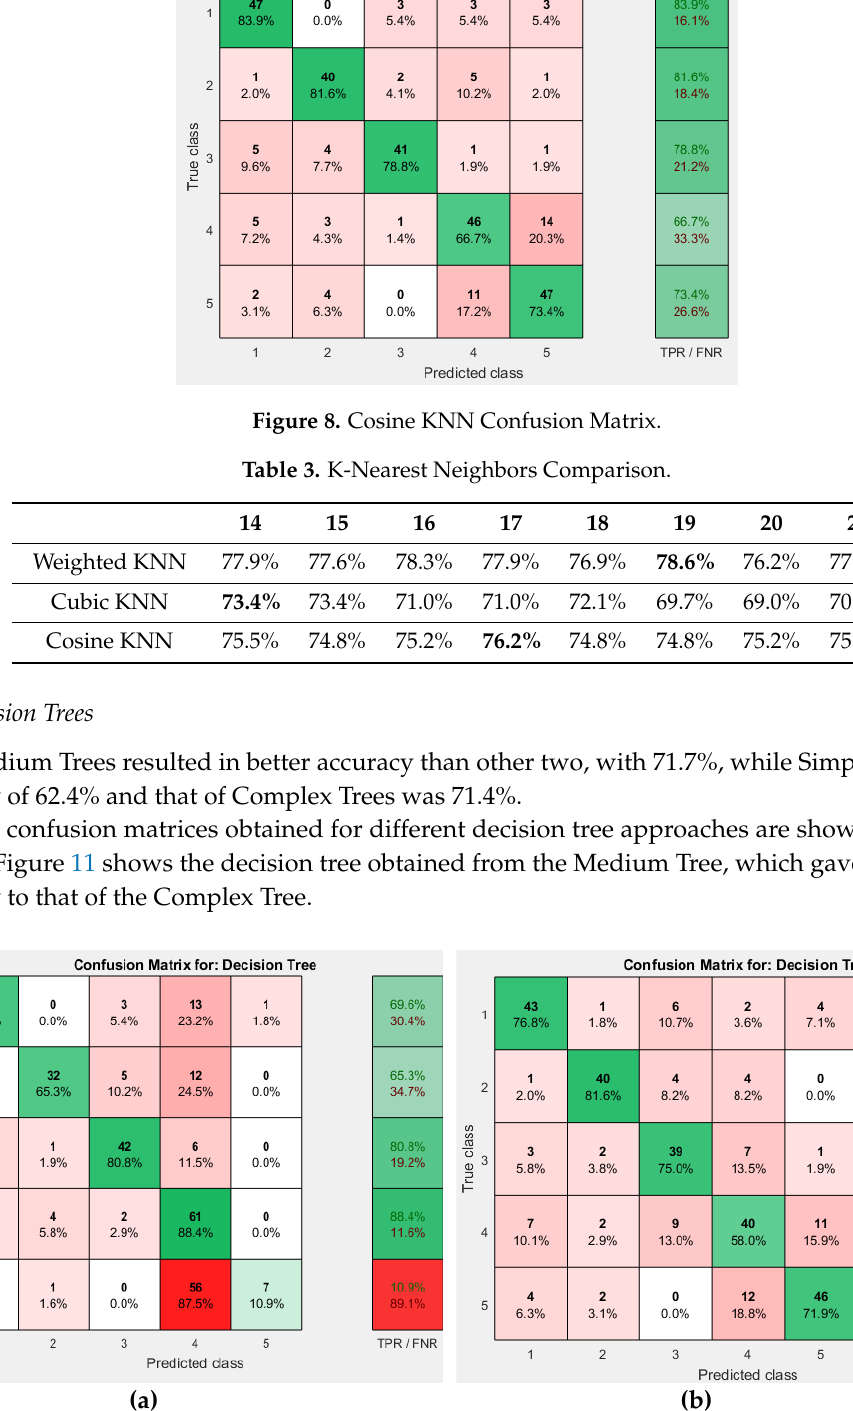
Figure 9. Decision Tree Confusion Matrix. ( a ) Simple Tree ( b ) Medium Tree.